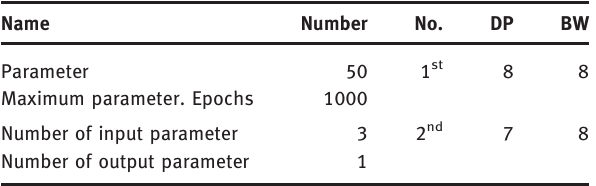
Table 9: Second bead on plate welding conditions employed for process